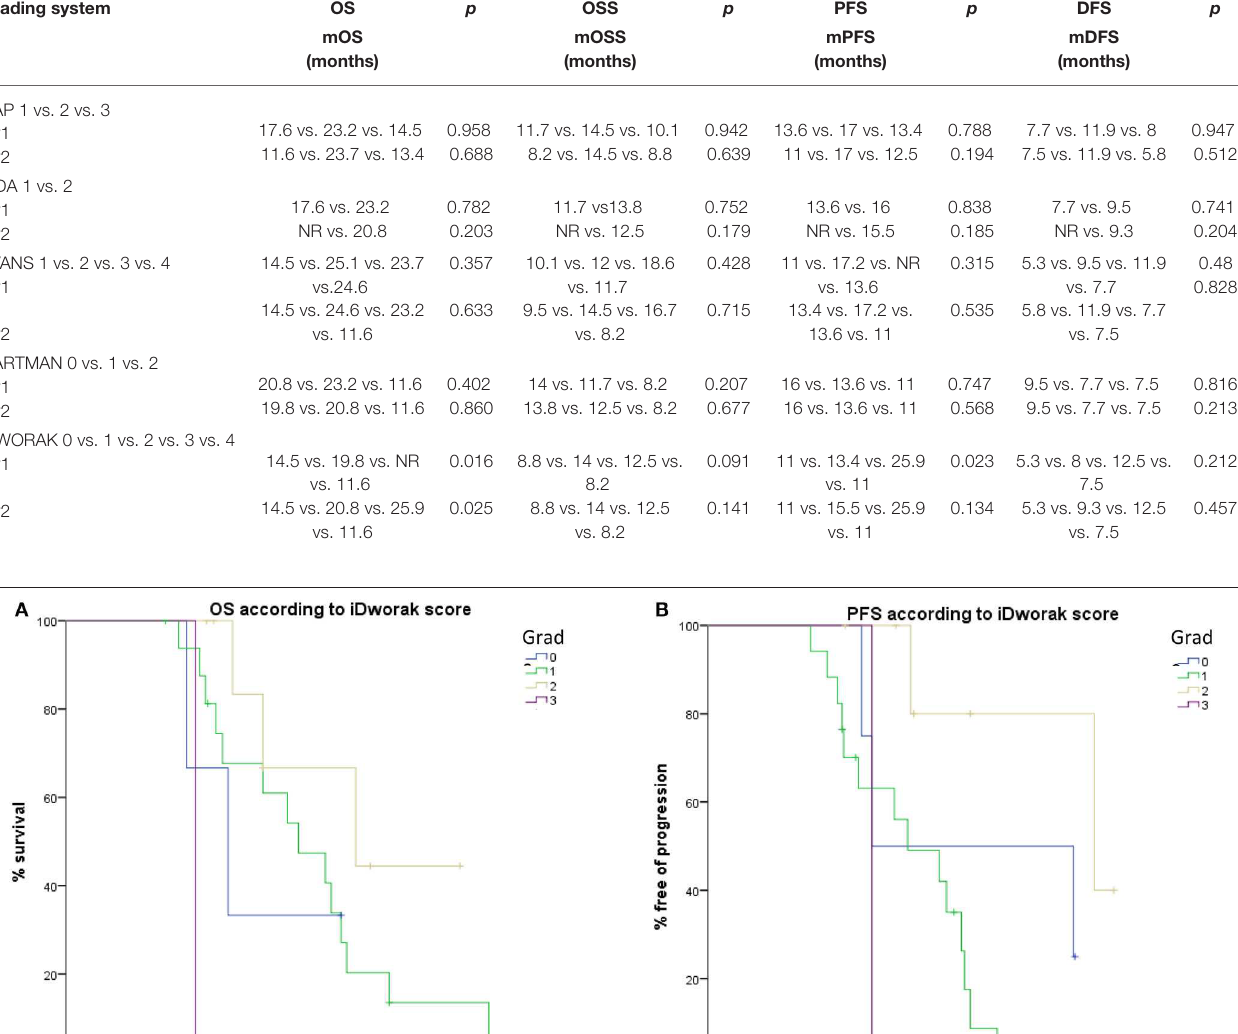
TABLE 4 | #P1: Pathologist 1; #P2: Pathologist 2. Grading system